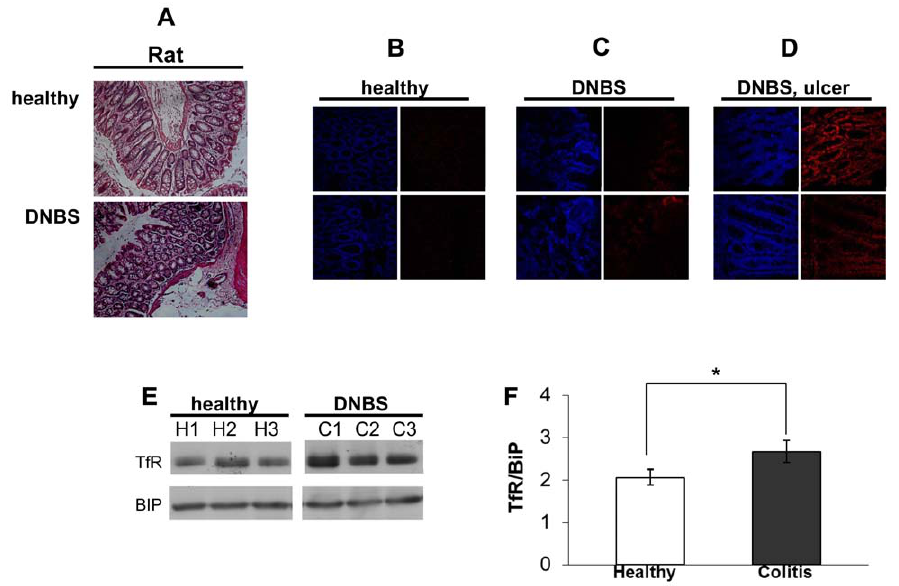
Figure 4. TfR expression is elevated in the mucosa of DNBS induced rats. (A) Hematoxylin and eosin staining of rat colon specimens taken from DNBS-induced rats 4 days after colitis induction and from healthy rat colonic mucosa.TfR immunostaining of transverse sections taken from the mucosa of vehicle treated (B), DNBS-induced (C) and ulcerated region in the DNBS-induced (D) rats. Left panels: nucleus staining (blue). Right panels: TfR staining (red). Magnification: 6 25; (E) immunoblot analysis of protein extracts (40 m g per lane) taken from the colon mucosa of sham treated (‘‘healthy’’) or inflamed mucosa from DNBS-induced rats. Anti-TfR (95 kDa) was used for staining. (F) Blots quantification was performed by densitometry and normalized to BiP (78 kDa). P-value , 0.05 was obtained by Mann-Whitney test.